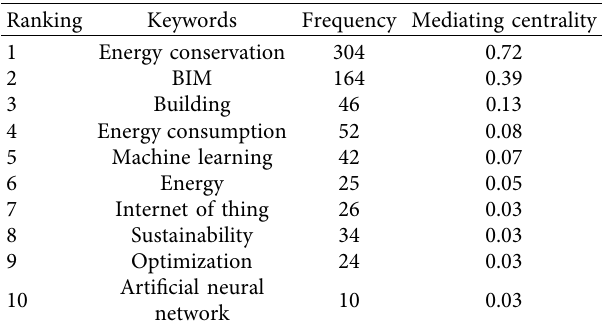
Figure 5: Keyword co-occurrence network. Table 3: Te top 10 mediating